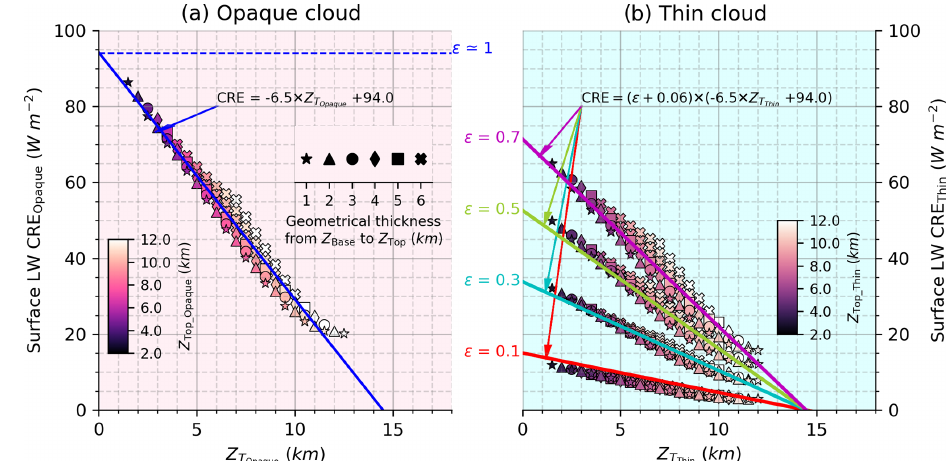
Figure A1. Same as Fig. 3 but over land.